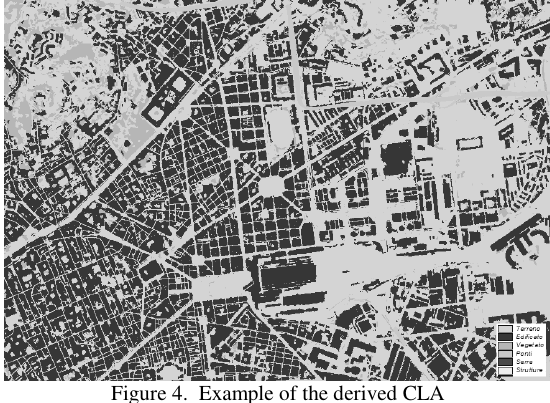
Figure 4. Example of the derived